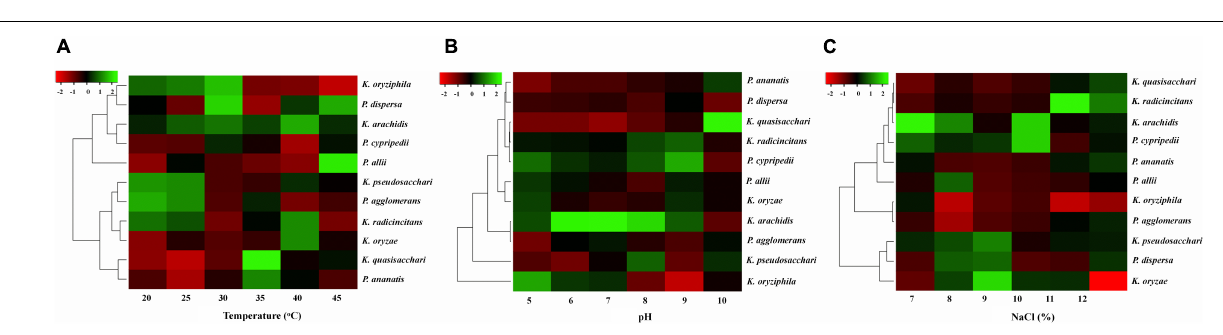
FIGURE 6 | Effects of different abiotic stresses on selected isolates. (A) Temperature, (B) pH level, and (C) Different concentrations of